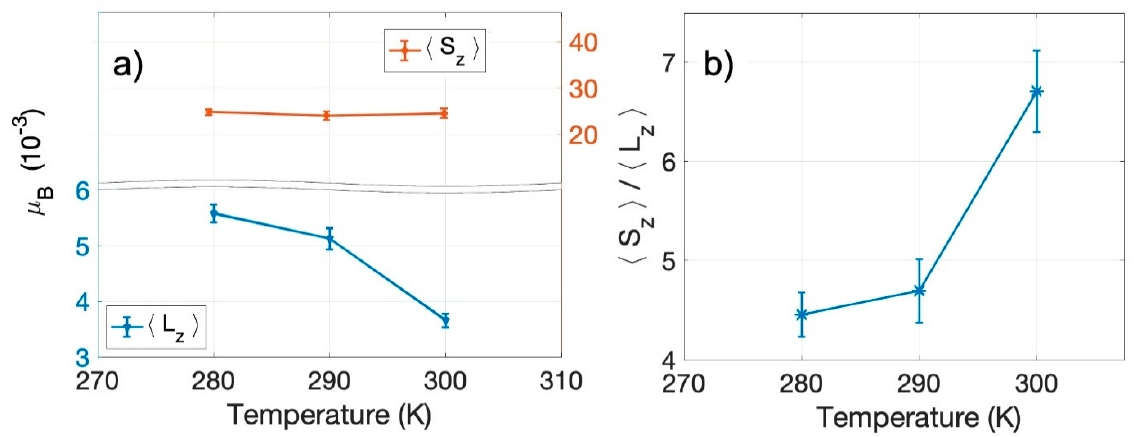
Figure 3. The Fe 2p 3/2 and 2p 1/2 (L 3 and L 2 edges) XMCD spectra of 30 nm [Fe{H 2 B(pz) 2 } 2 (bipy)] thin films on graphite. ( a ) The spectra were taken at 280 K (green), 290 K (red) and 300 K (blue). ( b ) The Fe 2p 3/2 and 2p 1/2 (L 3 and L 2 ) XMCD spectrum taken at 280 K (blue curve) compared to the integrated XMCD signal (red curve). The XMCD spectra are plotted as a percentage of the total X-ray absorption spectra.